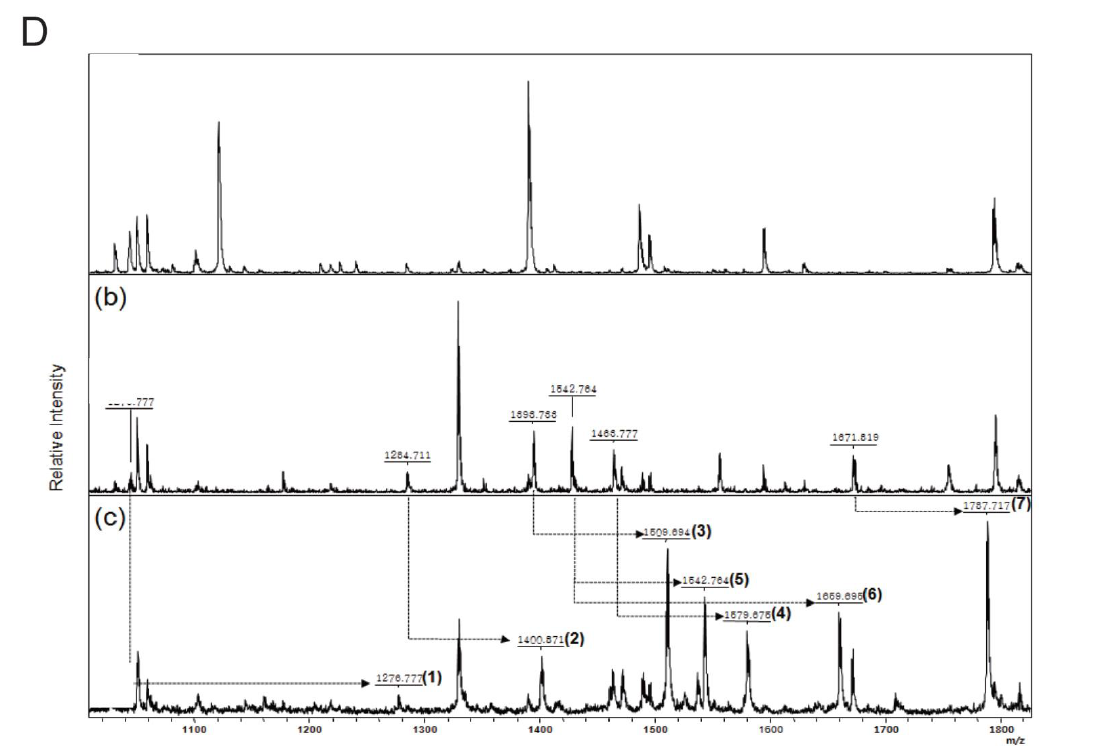
Figure 1. Citrullination of fibrinogen at α , β , and γ chains in the presence of peptidylarginine deiminase (PAD). ( A ) Level of citrullinated fibrinogen in synovial fluid (SF) from two osteoarthritis (OA SF1, OA SF2) and two rheumatoid arthritis (RA SF1, RA SF2) patients was detected by immunoprecipitation (IP) with anti-fibrinogen antibody and Western blot (WB) using anti-modified citrulline antibody. Coomassie, corresponding to each WB, of total protein in synovial fluid. Arrows indicate corresponding bands for α , β , and γ chains of fibrinogen. Fibrinogen from RA SF was more citrullinated than OA SF. ( B,C ) Spots for the α , β , and γ chains shifted in two-dimensional mapping of fibrinogen in the absence (B, upper row) or presence (C, upper row) of PAD2 (PAD). Shifts due to citrullination were confirmed by WB using anti-citrullinated fibrinogen antibody (lower rows of B and C). Arrows indicate corresponding spots between two-dimensional electrophoresis (2DE) and WB at a designated pH. ( D ) Citrullination sites (five in α , two in β , and one in γ chains) were detected by mass spectrometry via modification with phenylglyoxal monohydrate (PGM). Top panel = bovine fibrinogen (Fib.), Middle panel = Fib. + PAD, Bottom panel = Fib. + PAD +